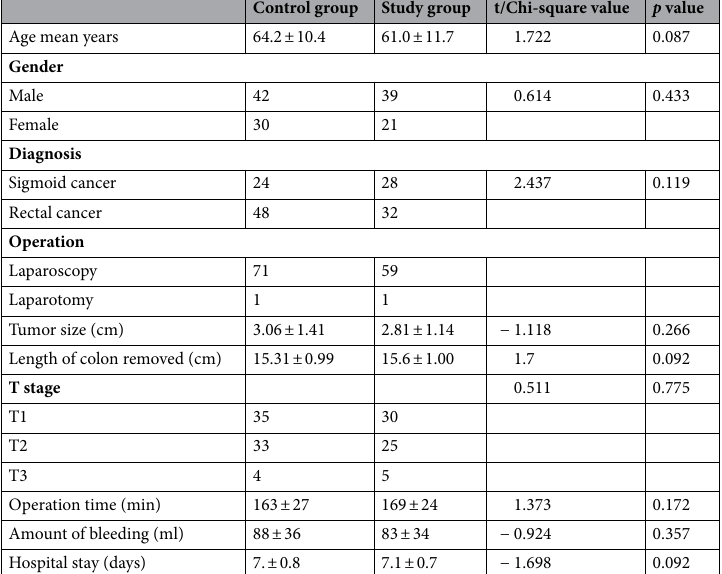
Table 1. The clinical characteristics of the patients stratified by group.